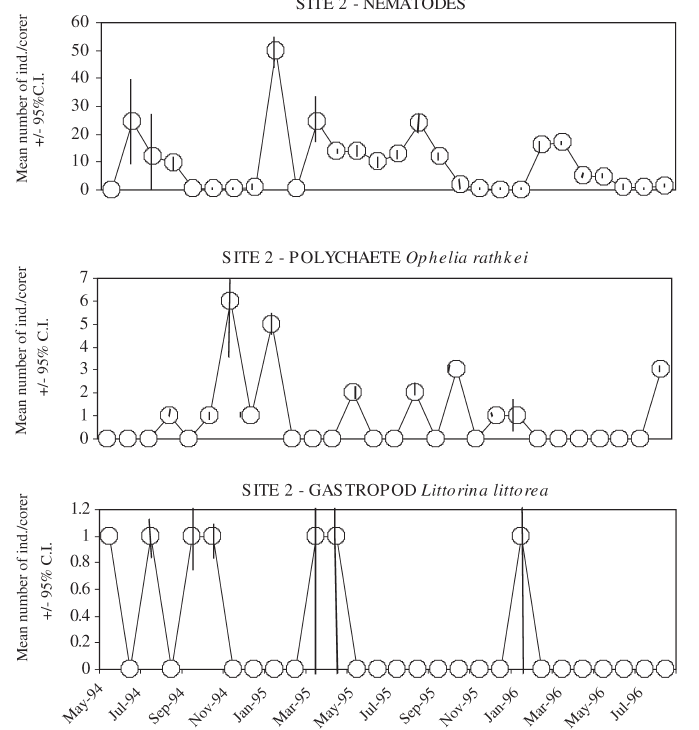
Fig . 6. – Mean abundance of some of the most conspicuous species at Site 2, Culbin Sands lagoon, NE Scotland during 1994-1996 (confidence intervals, C.I., when not fully represented, can be obtained from the symmetrical